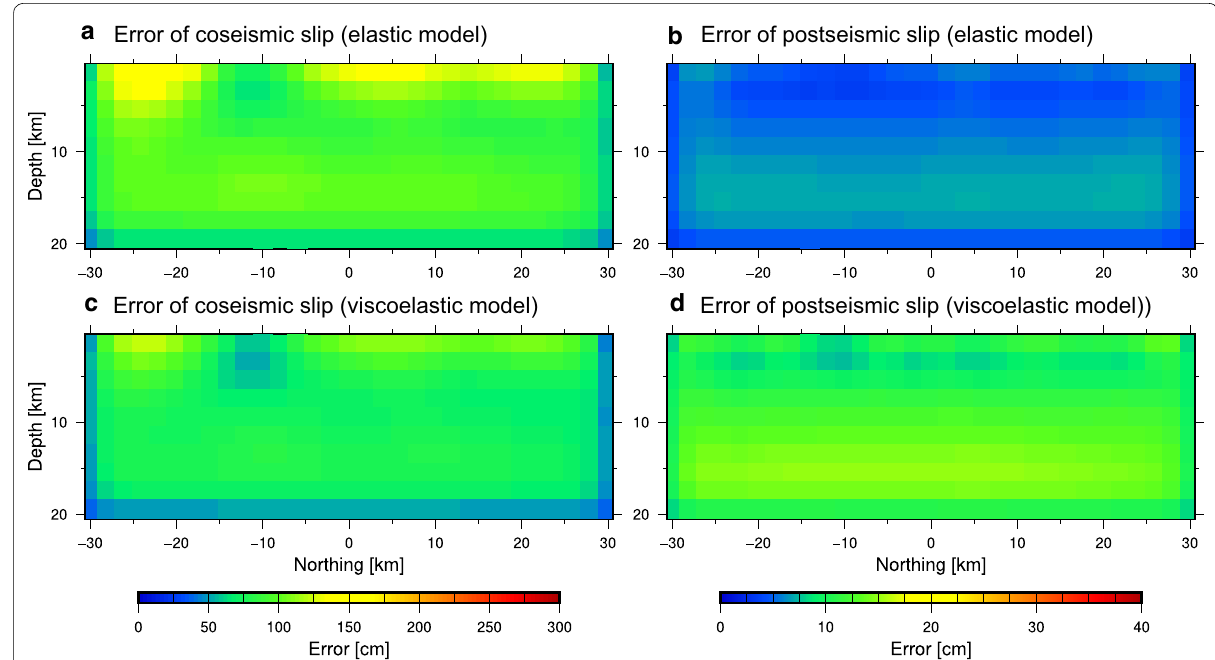
Fig. 3 Estimation errors for the strike–slip case. a , b The estimation errors of the co- and post-seismic slip distributions in the elastic model for the strike–slip case, respectively. c , d The estimation errors of the co- and post-seismic slip distributions in the viscoelastic model for the strike–slip case,